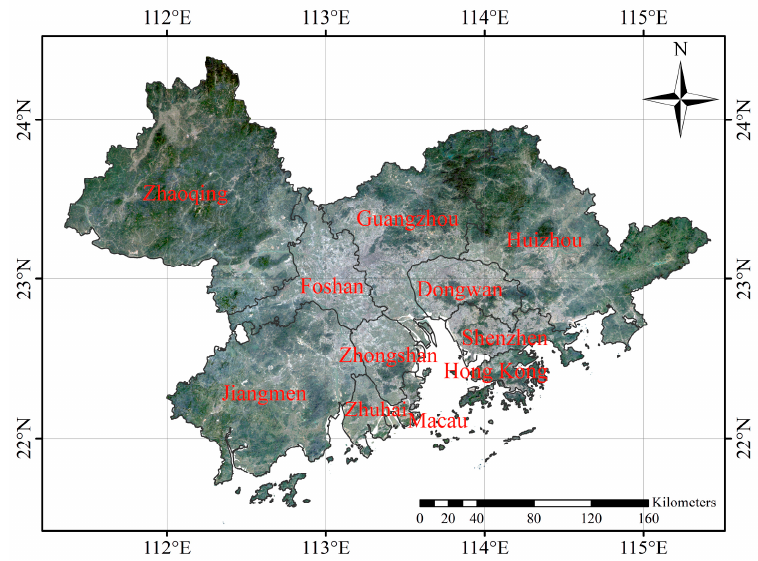
Figure 1. The location of Guangdong-Hong Kong-Macao Greater Bay Area.